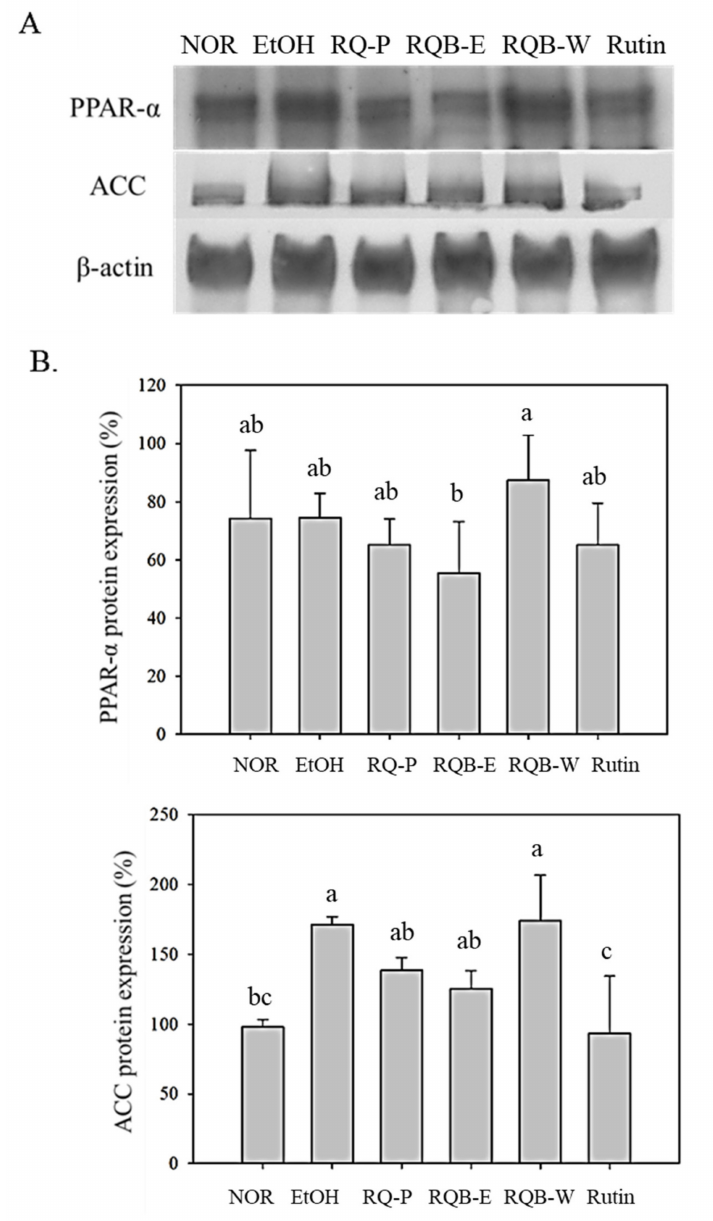
Figure 4. Expressions of ACC and PPAR- α in livers were detected by Western blot analysis ( A ). The levels of the proteins were subsequently quantitated by densitometric analysis ( B ). The data are presented as the means ± SD ( n = 8). The means followed by the same letter within each column did not differ significantly from each other ( p > 0.05). However, the means followed by different letter expressed significant difference from each other ( p < 0.05). Two groups of mice were fed with normal liquid diet (NOR group) or ethanol liquid diet (EtOH group) without the administration of test materials, respectively. The other mice fed ethanol liquid diet were administrated with red quinoa powder (5.13 g/kg B.W./day, RQ-P group), red quinoa bran ethanol extracts (1.54 g/kg B.W./day, RQB-E group), red quinoa bran water extracts (1.54 g/kg B.W./day, RQB-W group), and rutin (16.4 mg/kg B.W./day, Rutin group). ACC: acetyl CoA carboxylase; PPAR- α : proliferator-activated receptor